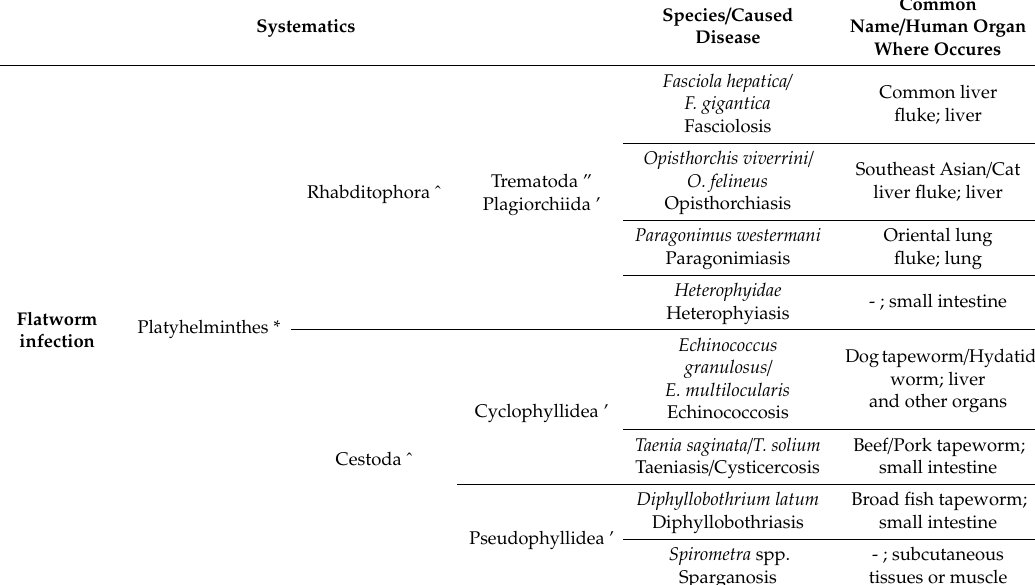
Table 2. Selected FBPs systematics. Taxonomy has been adopted from the National Center for Biotechnology Information (https: // www.ncbi.nlm.nih.gov / taxonomy). For the purposes of this work, slected species of FBPs from three main systematic groups (Platyhelminthes, Namatoda, and Protozoa) were listed. Additionally, the common name of the parasite was added if applicable, the name of the disase caused by each FBP, as well as the human organs where the parasites occure. Legend: *—phylum, ˆ—class, ”— clade,